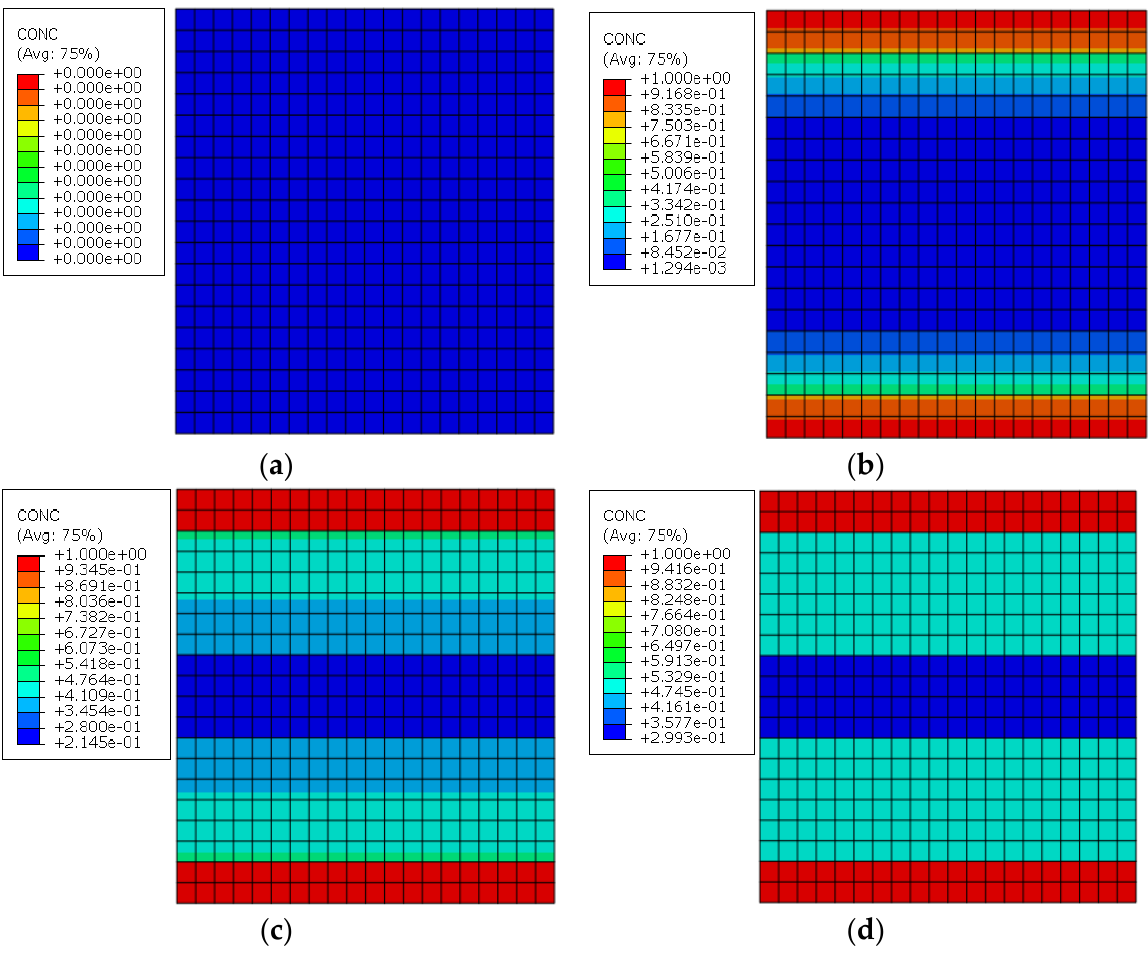
Figure 6. The concentration distribution of sandwich structure: ( a ) t = 0 h; ( b ) t = 20 h; ( c ) t = 200 h; ( d ) t = 800 h. Table 4. The diffusivity and saturated moisture content of flax, glass and jute fiber